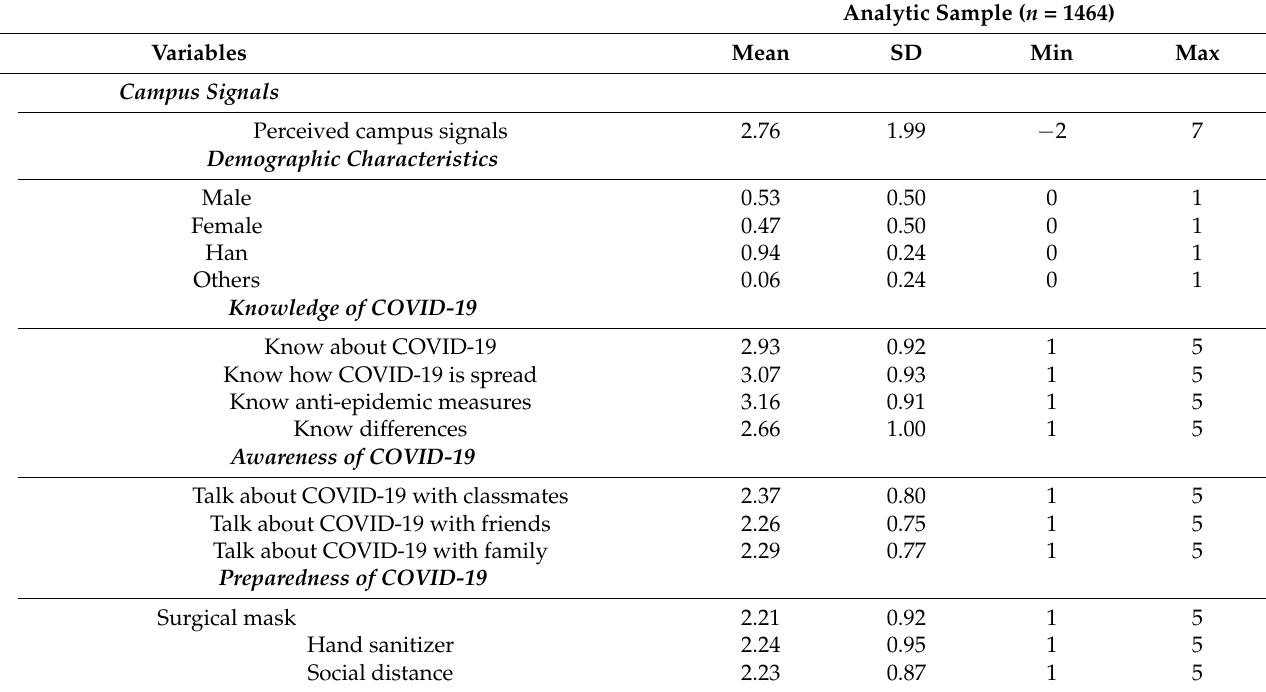
Table 2. Descriptive statistics of